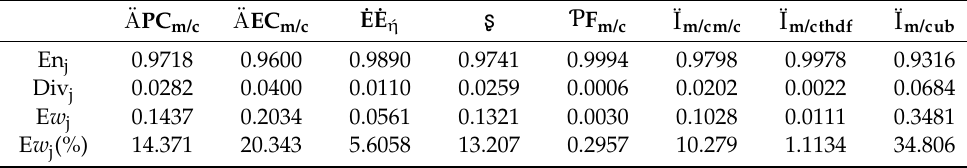
Table 14. Entropy-weights computation and weights.